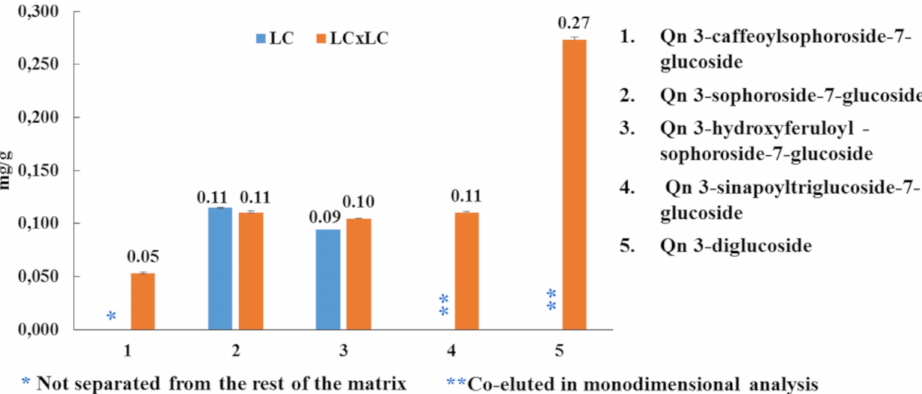
Figure 4. Semi-quantitative results (mg / g) for quercetin derivates using RP-LC and RP-LC ×